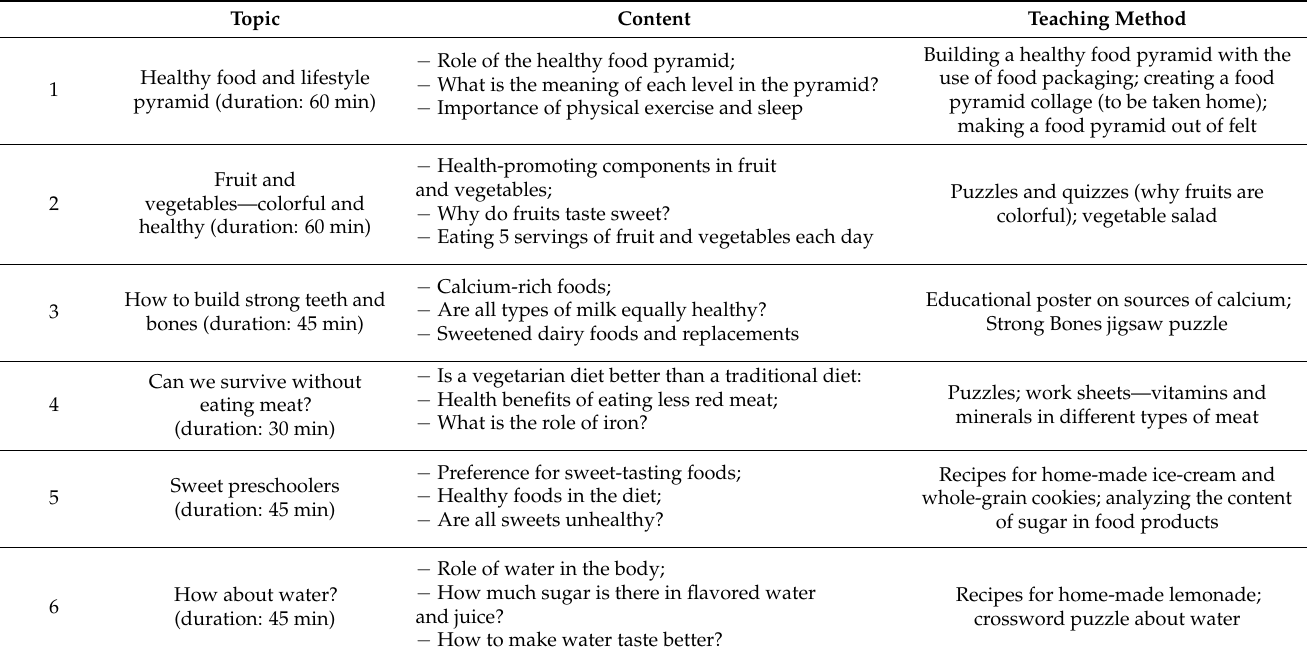
Table 1. Topics and content of nutrition education